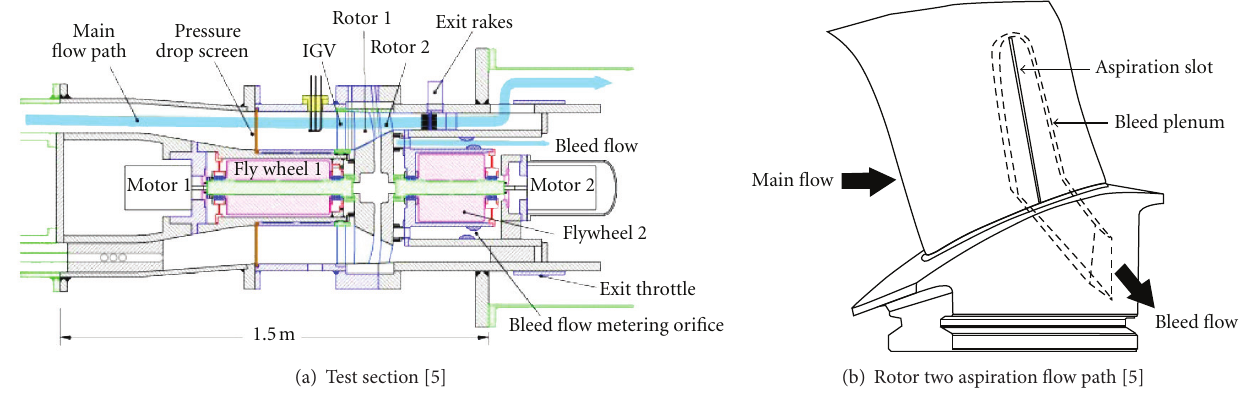
F 1: Test section and aspiration �ow paths.